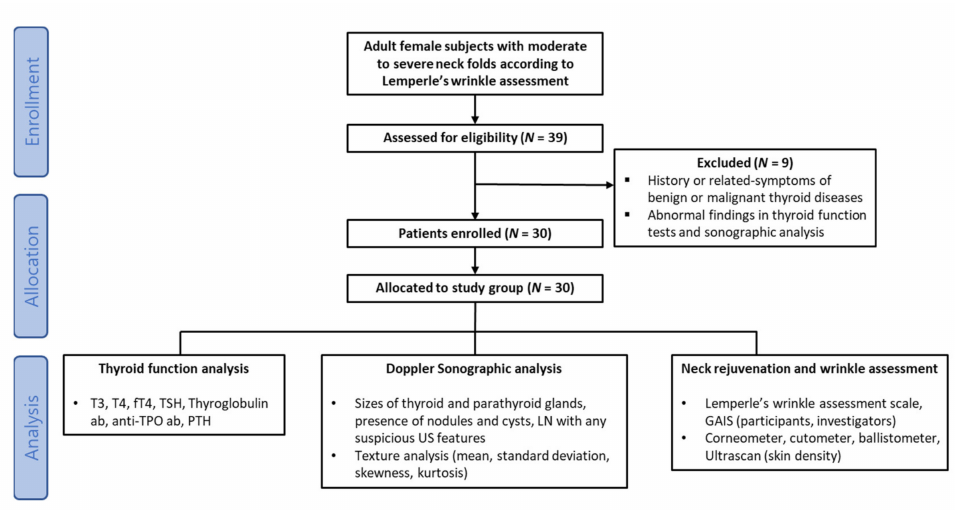
Figure 3. Flow-chart of participant screening and study design. T3, triiodothyronine; T4, thyroxine; fT4, free thyroxine; TSH, thyroid stimulating hormone; anti-TPO, anti-thyroid peroxidase antibody; PTH, parathyroid